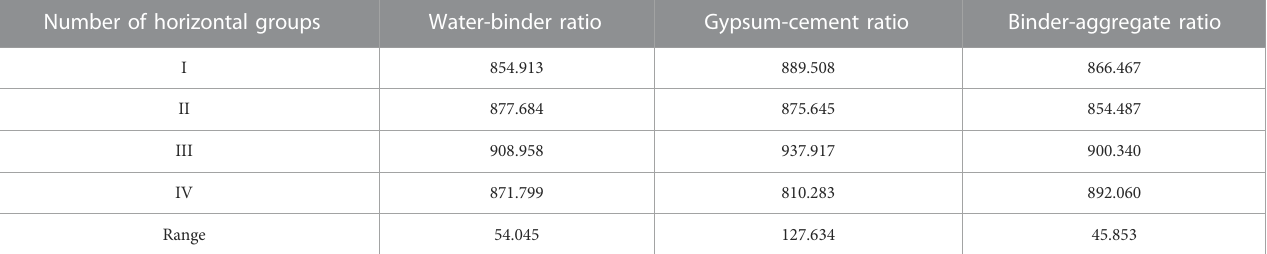
TABLE 10 Range analysis of deformation index.